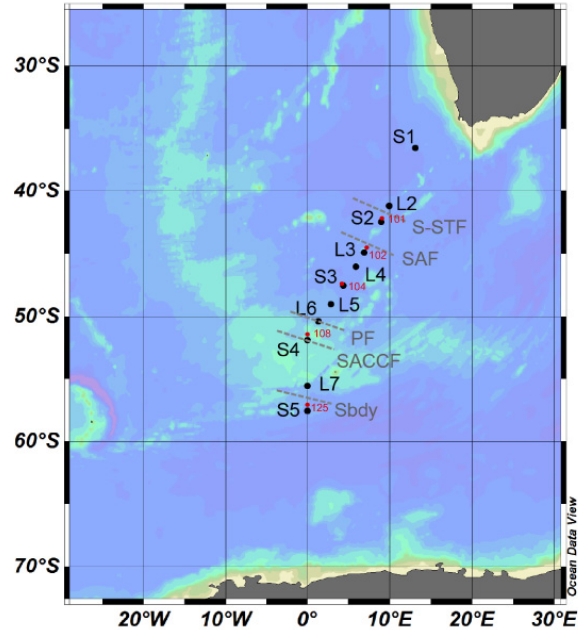
Fig. 1. Station location along the Bonus-GoodHope section (black dots); red dots are sites sampled for 234 Th during the ANTXXIV/3 expedition (see text). Also shown are the different frontal zones crossed during the BGH cruise: the southern Subtropical Front (S-STF), the sub-Antarctic Front (SAF), the Polar Front (PF), the southern ACC Front (SACCF) and the southern boundary (Sbdy). Schlitzer, 2003; Ocean Data View; http://www.awi-bremerhaven.